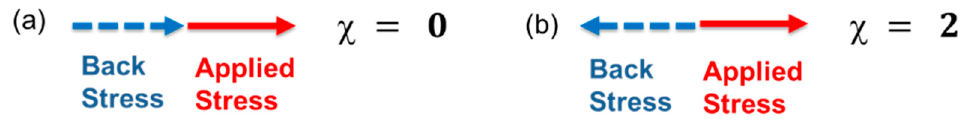
Figure 4. An illustration of the scalar parameter χ representation: ( a ) No di ff erence in the direction of the back-stress (blue dashed arrow) and the applied stress tensors (red solid arrow) makes χ = 0. ( b ) Opposite direction of the two tensors leads to χ = 2.